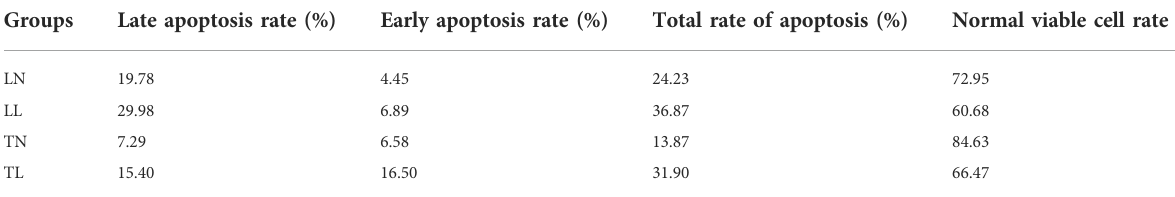
TABLE 1 Apoptosis rate of AT Ⅱ cells under hypoxia.